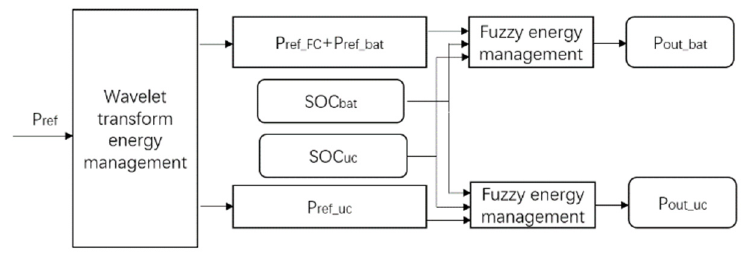
Figure 9. Wavelet-fuzzy energy management strategy.